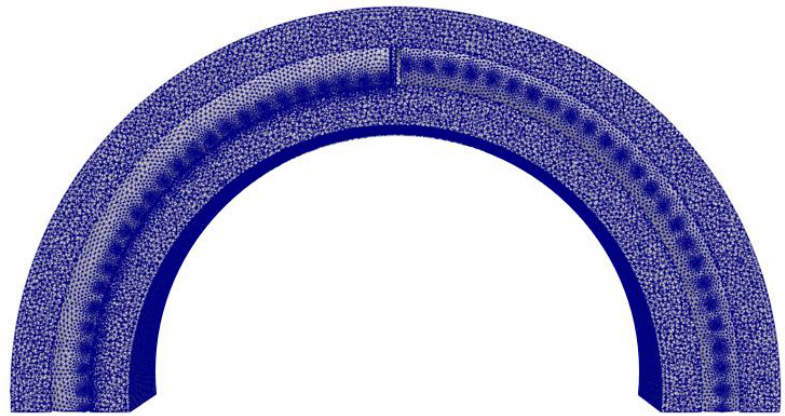
Figure 8. Mesh-close up of the interior mesh of fuel gas ring showing the burner